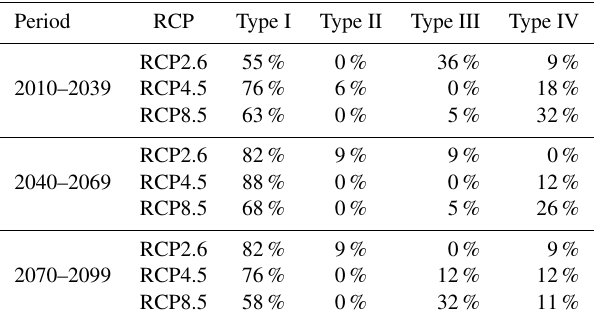
Table 5. Percent of economic risk cases falling in each type (I, II, III or IV) grouped by period and